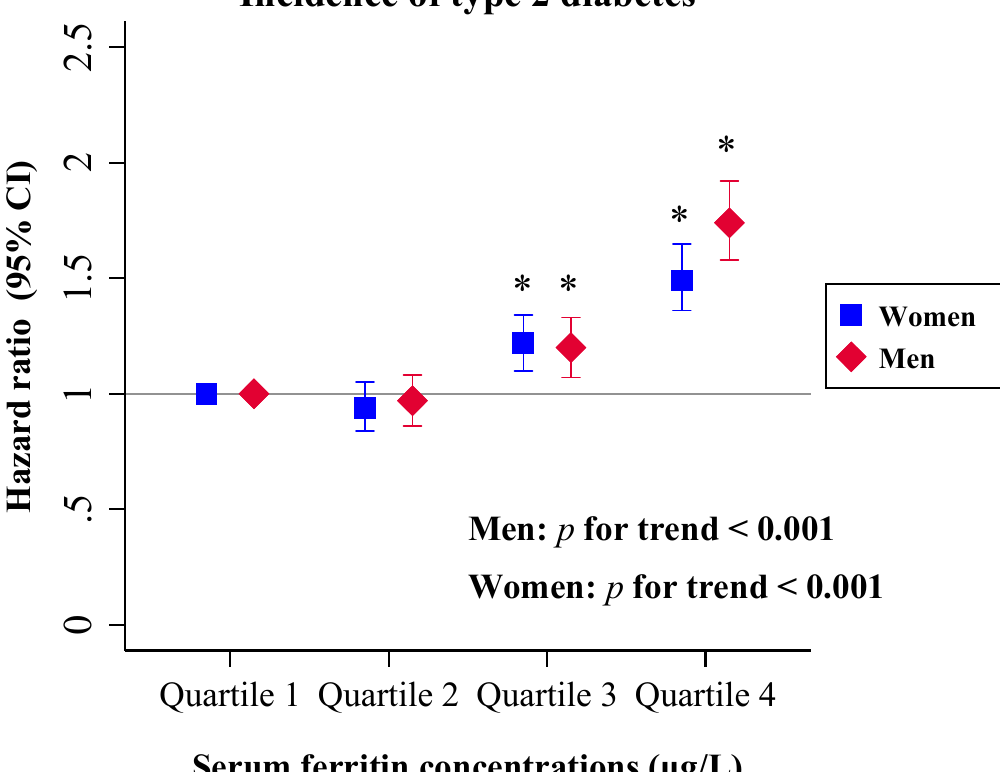
Figure 3. Cox proportional-hazards regression models were used to calculate HRs (95% CIs) for incidence of type 2 diabetes, according to the quartiles of serum ferritin ( µ g / L), separately for men (red diamond) and women (blue square). Serum ferritin quartiles (Q): Q1 ( ≤ 90.0 in men; ≤ 25.0 in women) (reference), Q2 (90.1–154.6 in men; 25.1–46.0 in women), Q3 (154.7–258.0 in men; 46.1–82.7 in women), and Q4 ( ≥ 258.1 in men; ≥ 82.8 in women). The Cox proportional-hazards regression models were adjusted for age (years), smoking (smoker, non-smoker or ex-smoker), risk levels for alcoholism (0, 1, or 2 and 3), dyslipidemia (yes or no), hypertension (yes or no) and body mass index (kg/m 2 ). The horizontal line represents hazard ratio = 1. * p < 0.05 versus 1st quartile of serum ferritin concentration. HR, hazard ratio; CI, confidence interval.